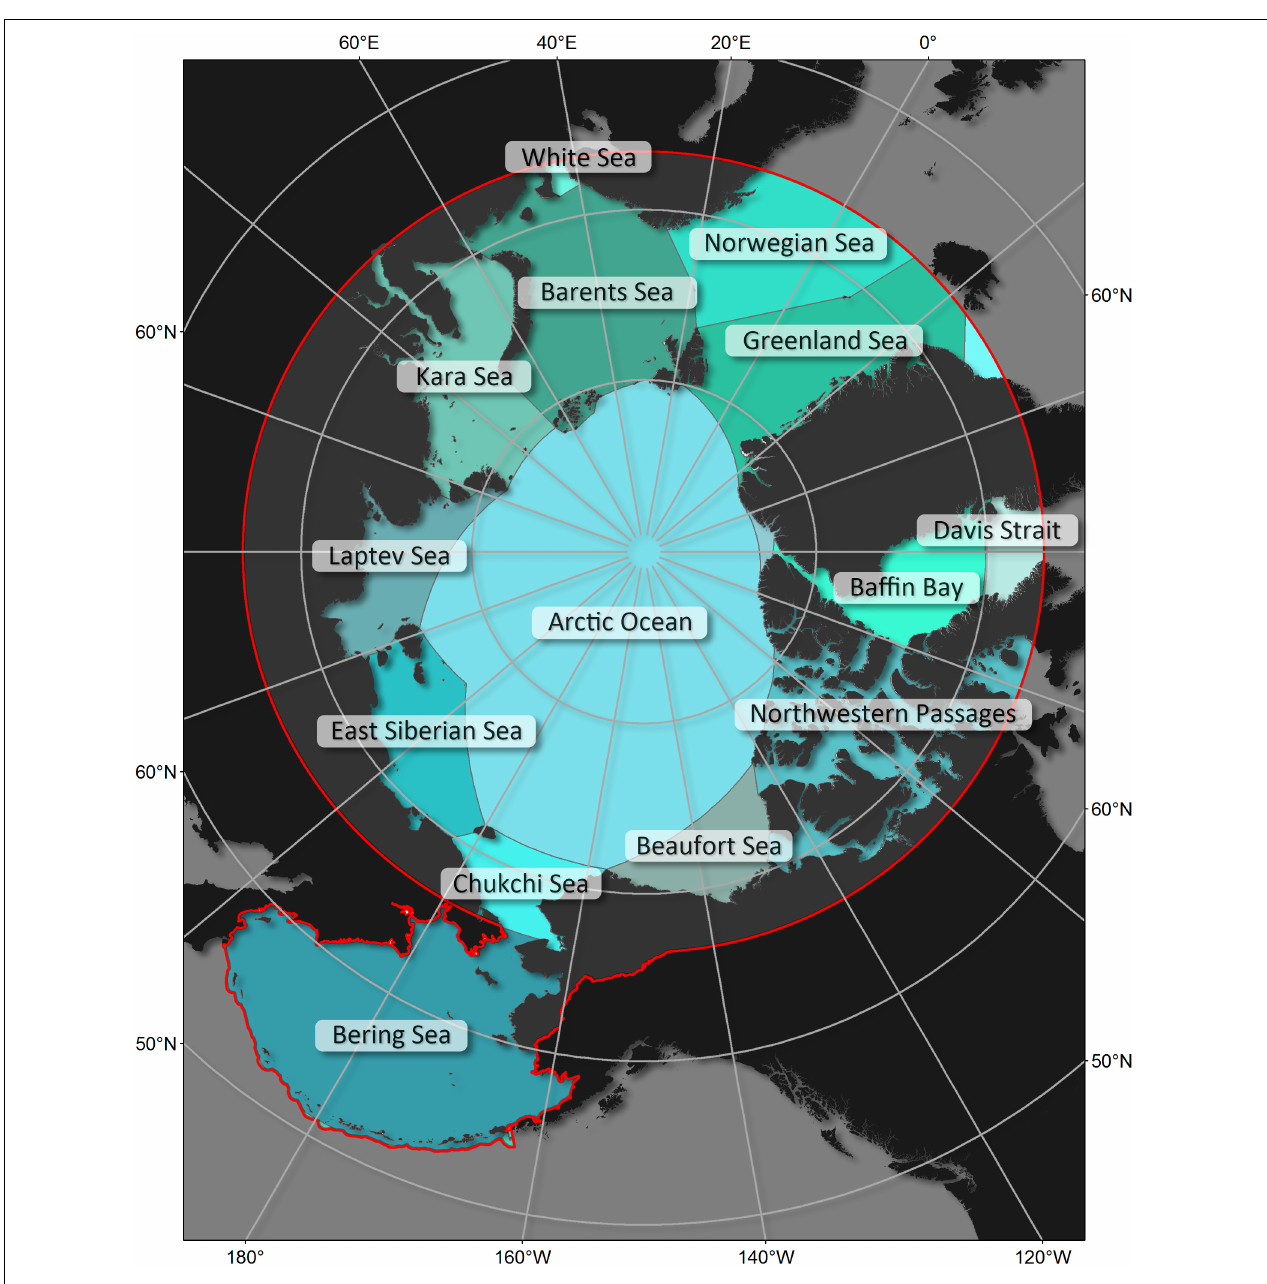
FIGURE 1 | Boundaries of study area as defined by the Arctic Research and Policy Act of 1984 and the 14 oceans, seas, bays, straits and passages within the boundary (International Hydrographic Organization Sea Areas).